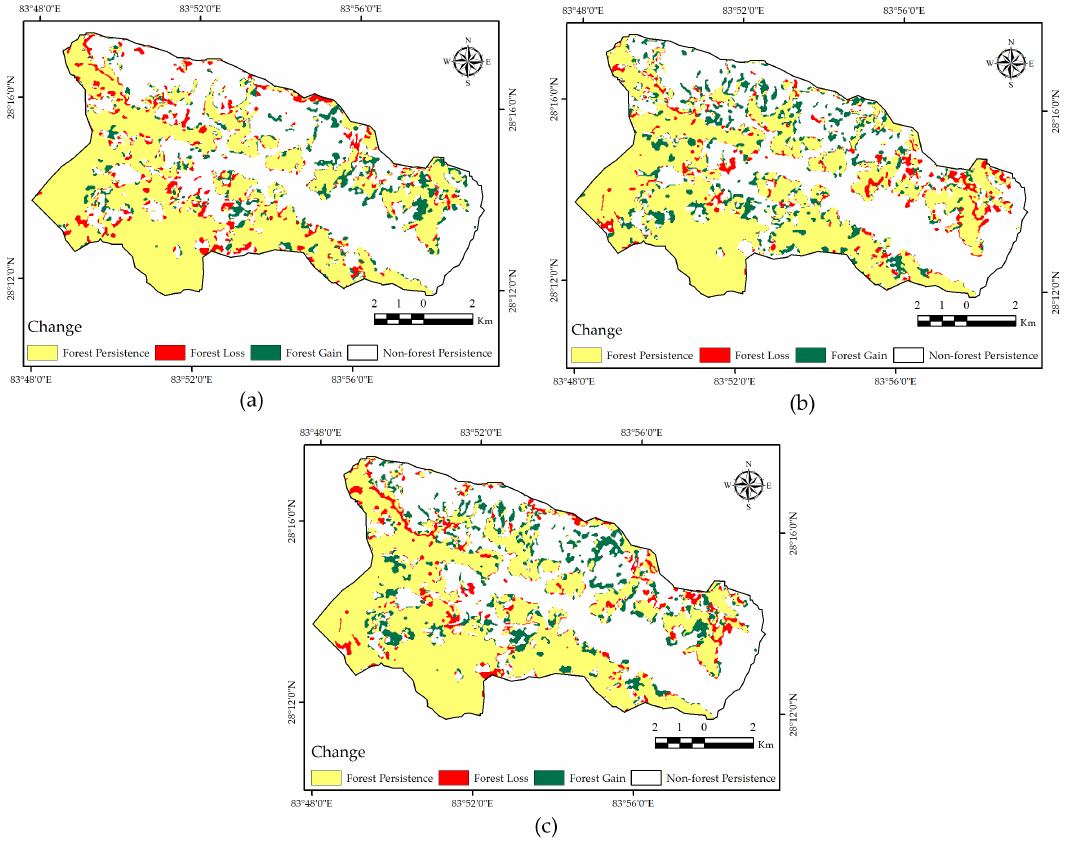
Figure 4. Forest cover changes in Phewa Lake Watershed during: ( a ) 1995–2005; ( b ) 2005–2017; and ( c )